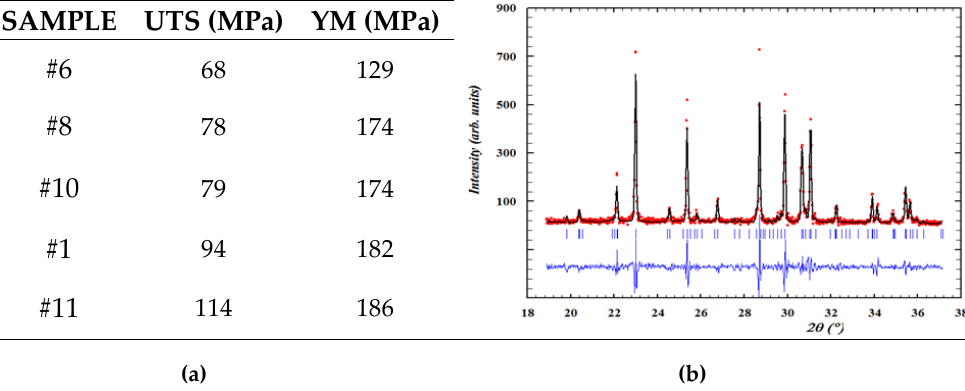
Figure 8. The table on the left ( a ) reports the mechanical properties of the sample, the ultimate tensile stress (UTS), and the Young’s modulus (YM). The XRD pattern ( b ) was obtained from powder. Rietveld analysis confirms the monoclinic structure of LYSO in terms of peak sequence and relative intensity. By SEM microscopy, surface finishing of samples has been observed. In Figure 9 a typical surface presenting no evidence of macro defects is